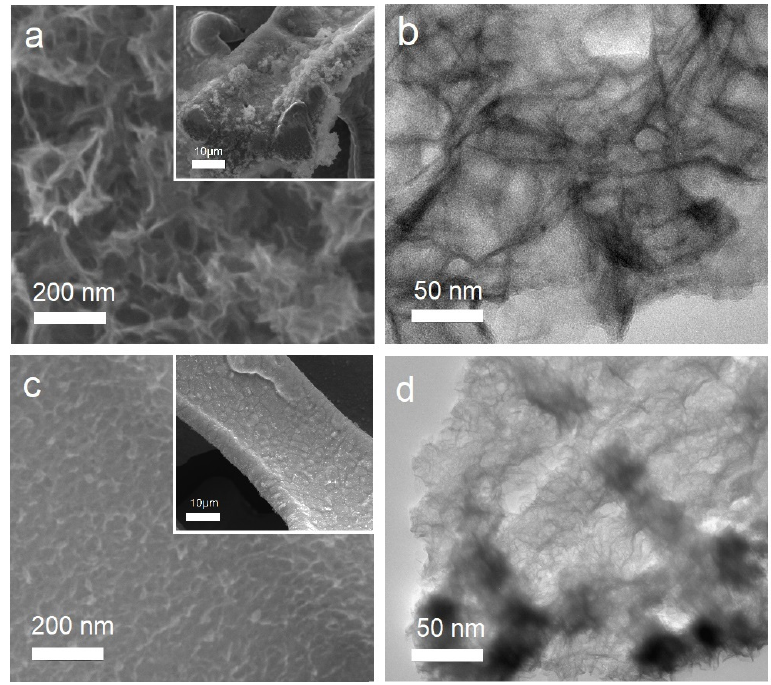
Figure 2. SEM and TEM images of MO1 ( a , b ) and MO2 ( c , d ), respectively.